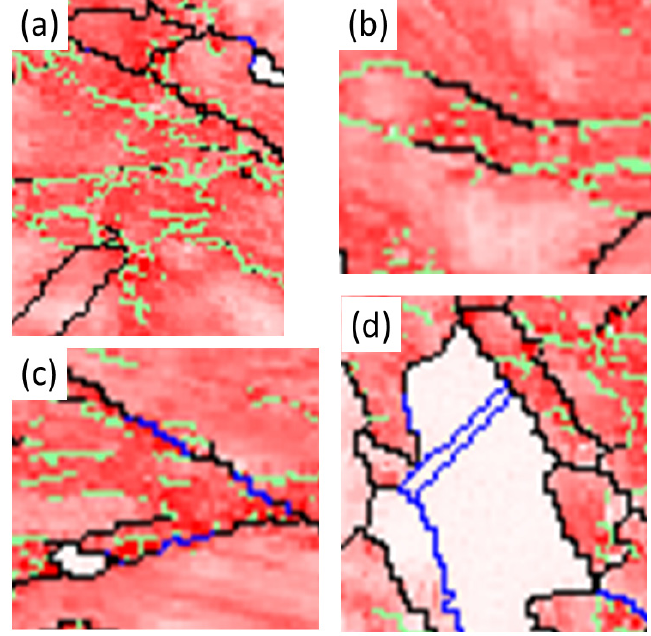
Figure 10. Magnification image of ( a ) A area with LAGBs; ( b ) B area with HAGB and LAGB; ( c ) C area with HAGB and CSL; and ( d ) D area with CSLs for 50% cold-rolled FePd alloy at 700 °C after 1 min. A, B, C and D symbols indicate the areas of image magnification marked in white dash lines in Figure